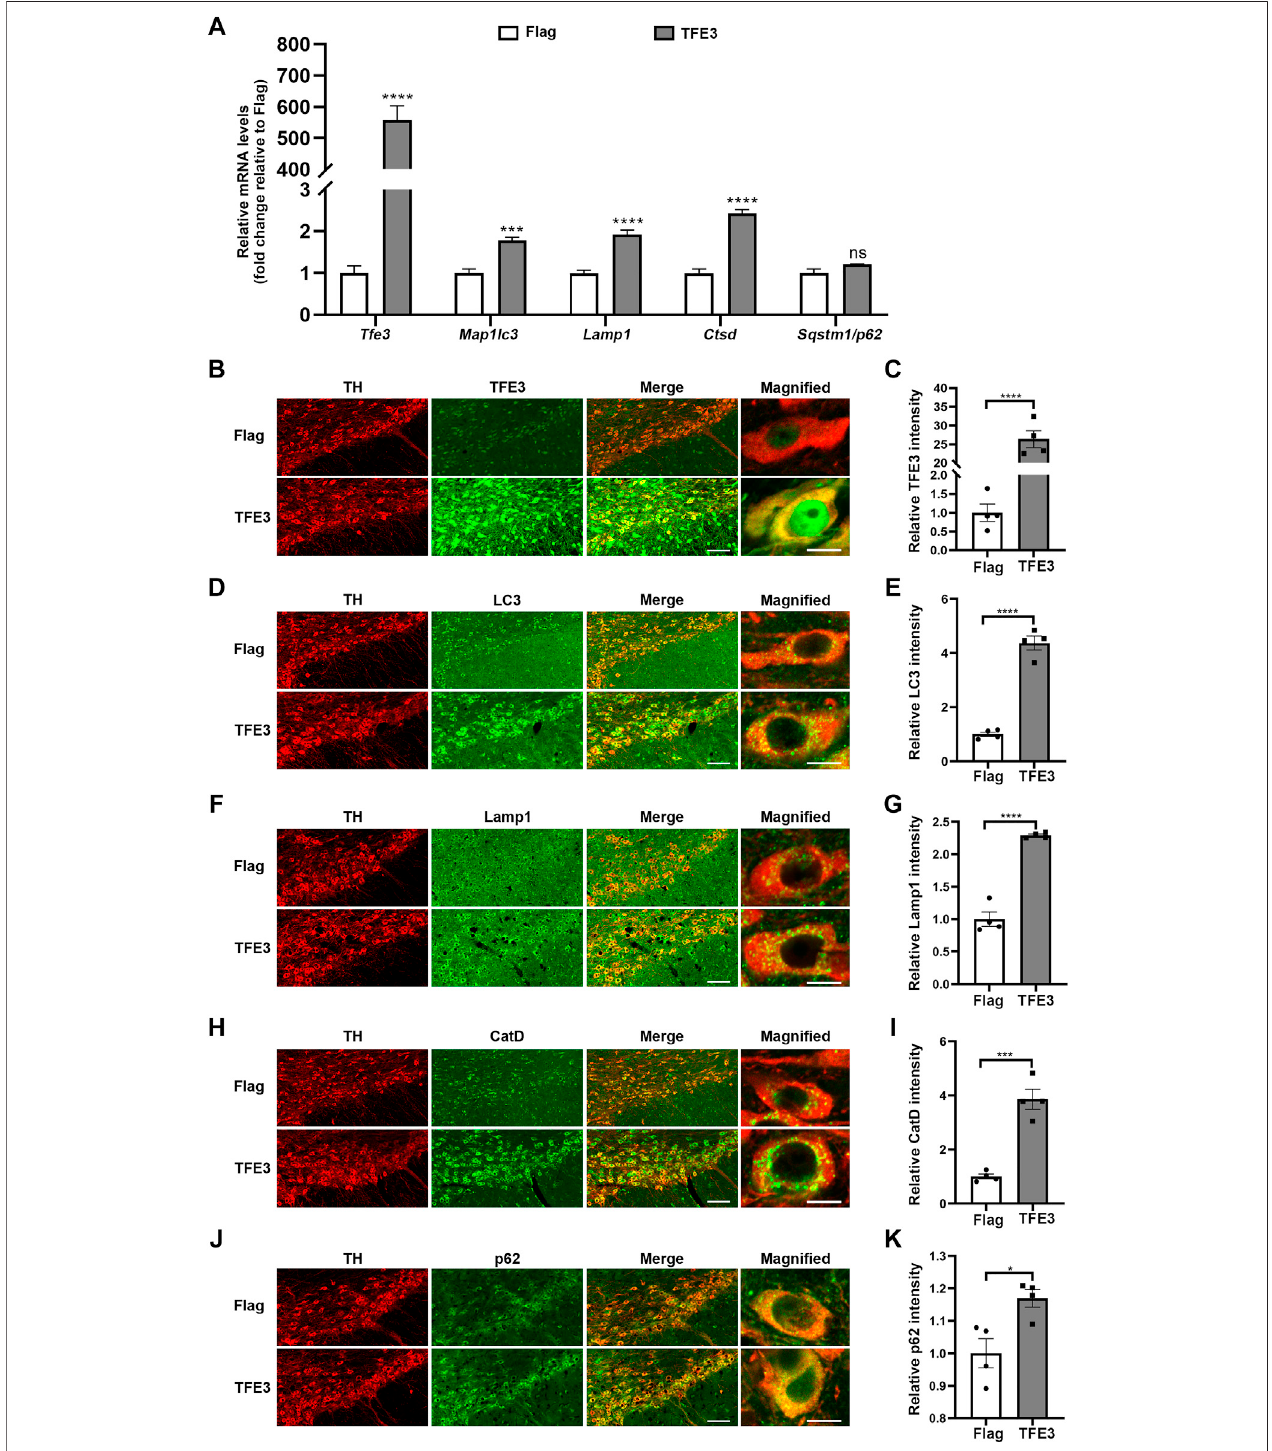
FIGURE 4 | TFE3 overexpression enhances autophagy in dopaminergic neurons. (A) Quantitative RT-PCR analysis of Tfe3 , Map1lc3 , Lamp1 , Ctsd and Sqstm1/ p62 mRNA in the SN of mice injected with AAV-Flag or AAV-TFE3. n (cid:1) 5 per group. (B, D, F, H and J) Representative images showing immuno fl uorescence for TFE3 (green, B), LC3 (green, D), Lamp1 (green, F), CatD (green, H) and p62 (green, J) in SN dopaminergic neurons (TH-positive, red) of mice injected with AAV-Flag or AAV- TFE3.n (cid:1) 4pergroup.Scalebars:lowmagni fi cation,100 μ m;highmagni fi cation,10 μ m. (C,E,G,IandK) Quantitativedataareshown.Dataareexpressedasthe mean ± SEM. * p < 0.05, *** p < 0.001, **** p < 0.0001, ns, not signi fi cant, two-tailed Student ’ s t test.